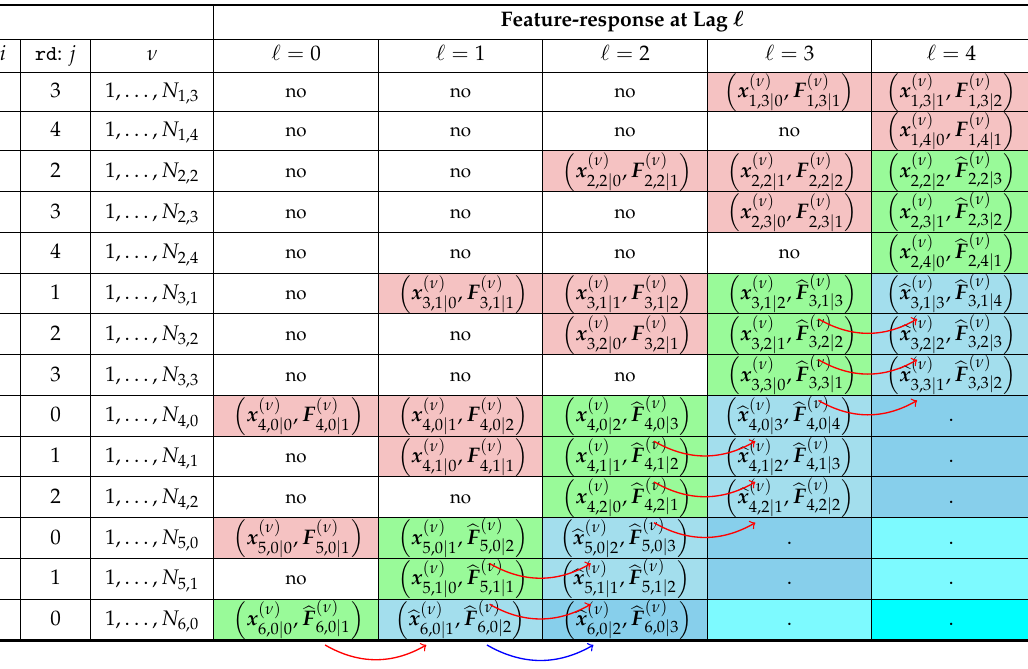
Table 7. Creating “future diagonals” by multiyear